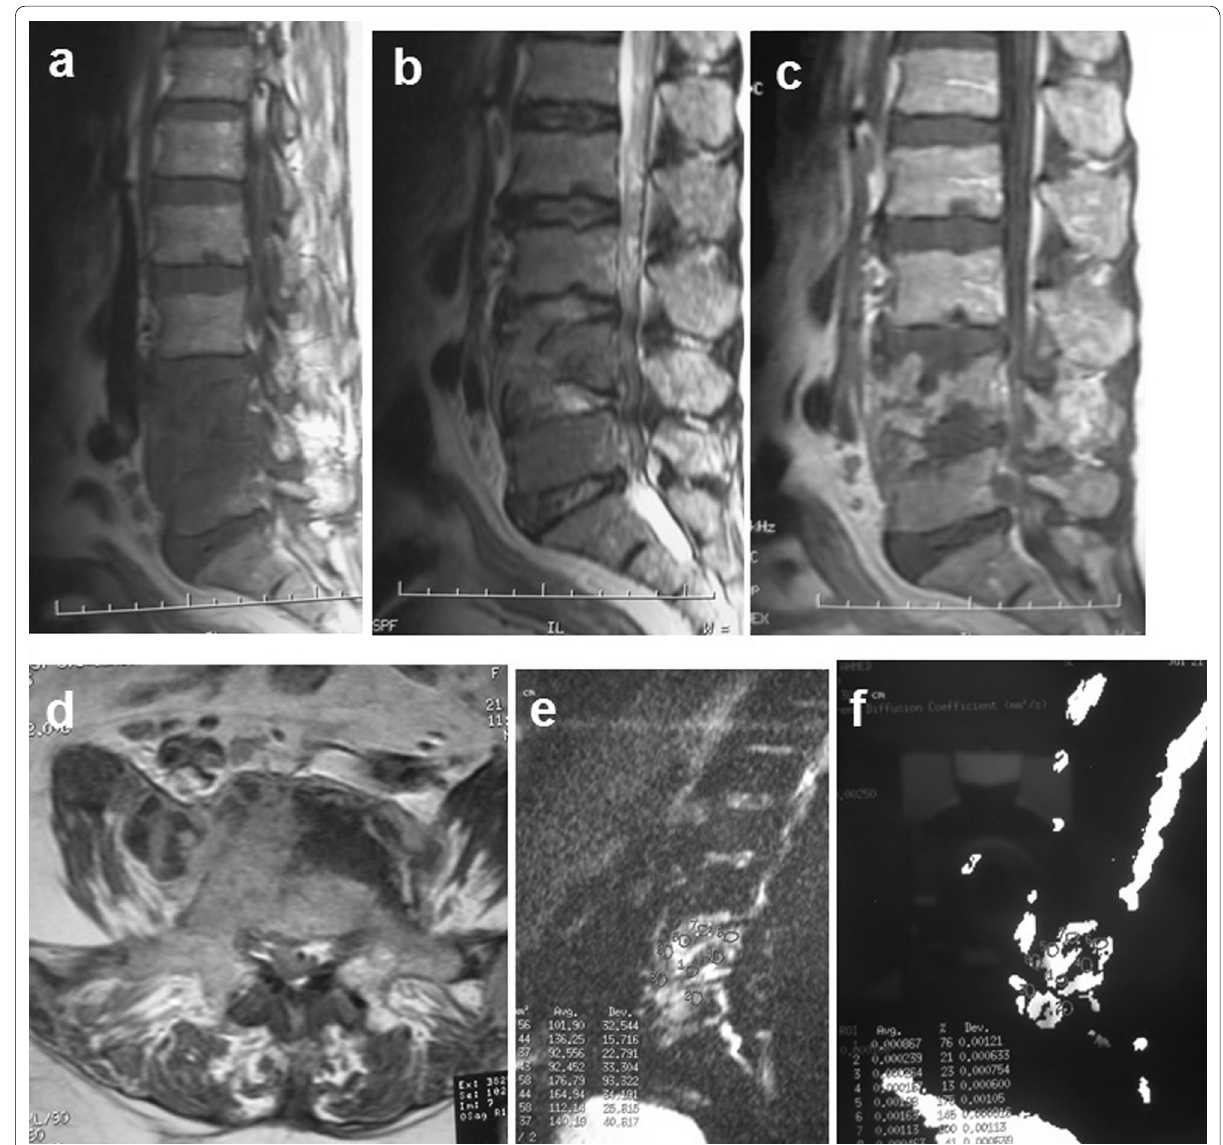
Fig. 3 A 47-year-old woman with L4 wedging (TB spondylodiscitis). Sagittal T1 ( a ) and T2 ( b ) images show the L4 wedging, eroded end plates with diffuse bone marrow low signal at T1 images and bright T2 signal of L4-5 disc. Post-contrast sagittal T1 ( c ) and axial T1 ( d ) show L4 bone marrow and L4-5 disk heterogeneous contrast enhancement with pre-, paravertebral collections and subtle epidural soft tissue component. Sagittal DWI image ( e ) shows bright signal that shows on ADC map ( f ), mean value of